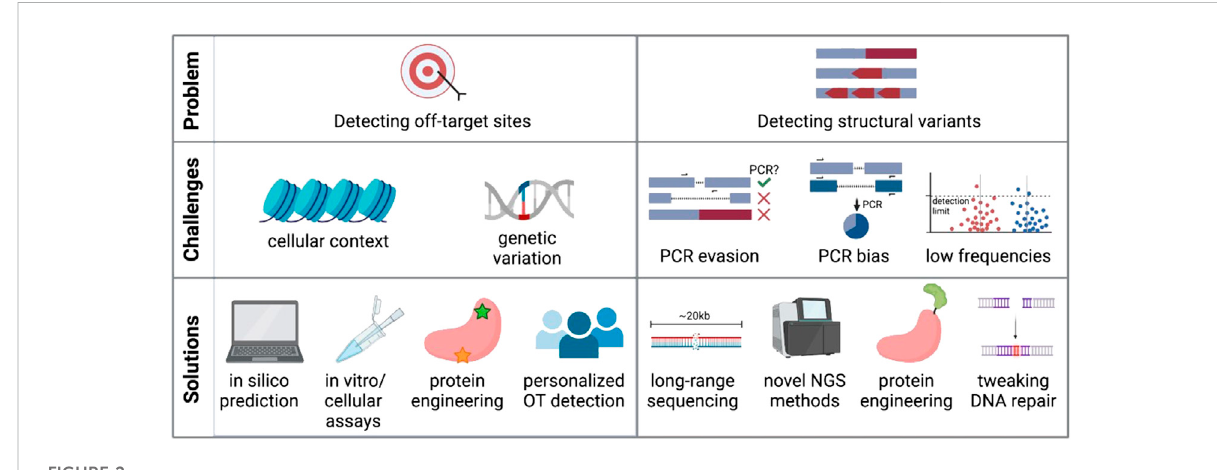
FIGURE 2 Challenges and potential solutions of current off-target detection methods. Created with